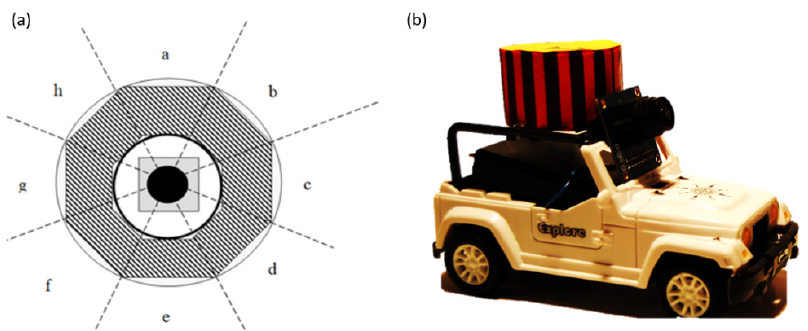
Figure 5. ( a ) The location of distance detectors with markers of the assumed distance between robots. ( b ) A photograph of a real model with a marker.